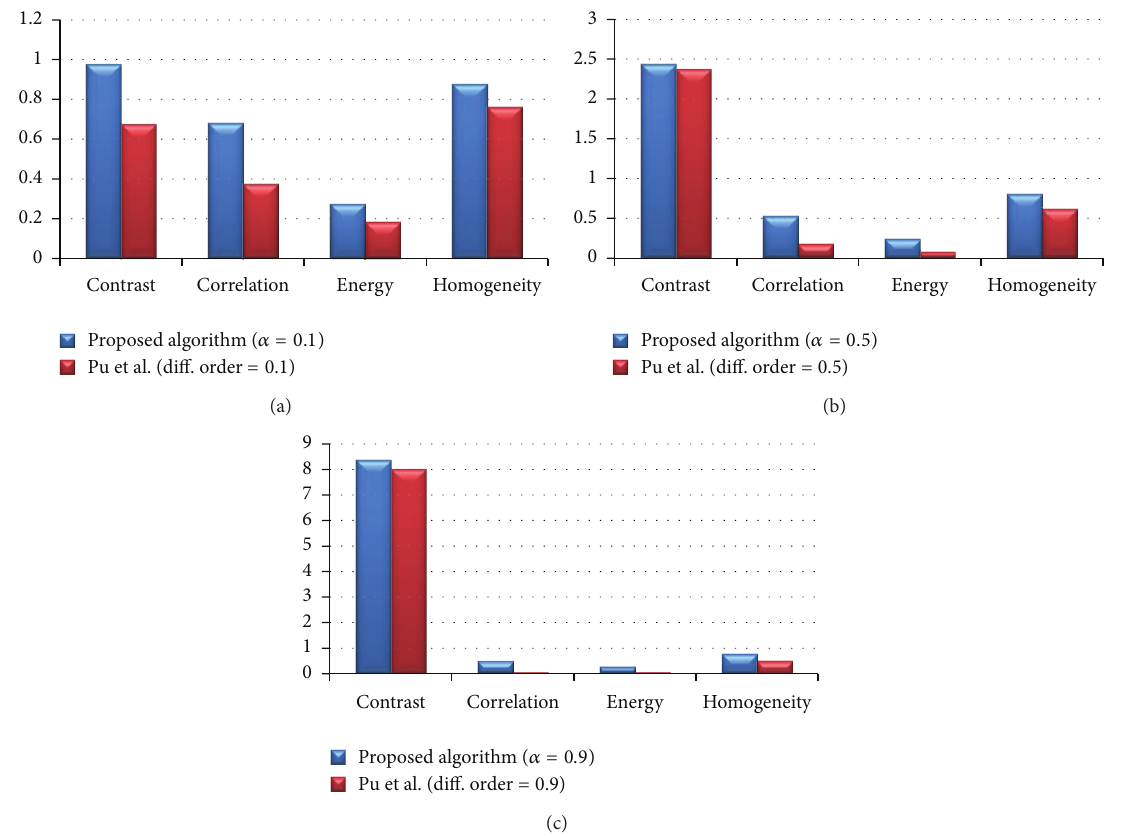
Figure 6: Comparison of texture enhancement with other works for different values of 𝛼 : (a) 𝛼 = 0.1 , (b) 𝛼 = 0.5 , and (c) 𝛼 = 0.9